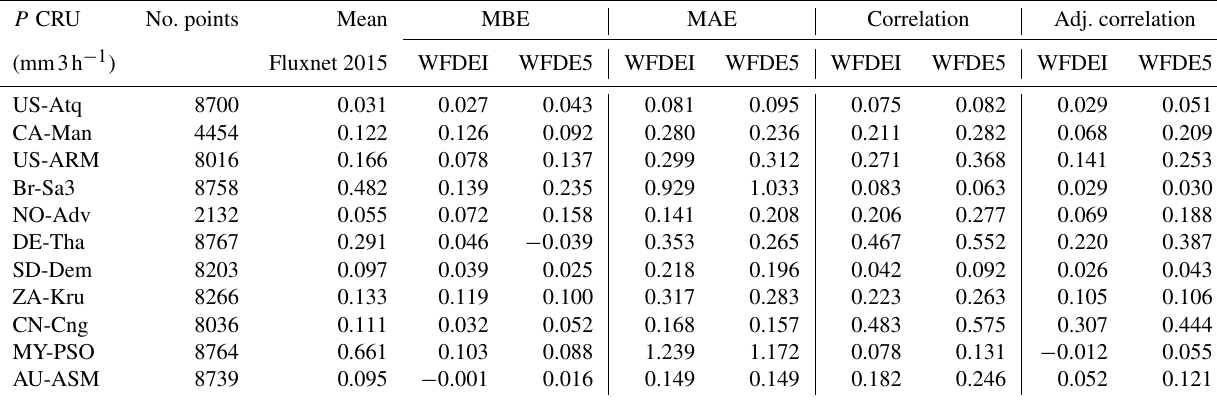
Table A15. Precipitation (Rainf + Snowf) metrics, corrected using CRU totals, for each FLUXNET2015 site: WFDEI versus FN2015 and WFDE5 versus FN2015 at 3-hourly time steps.